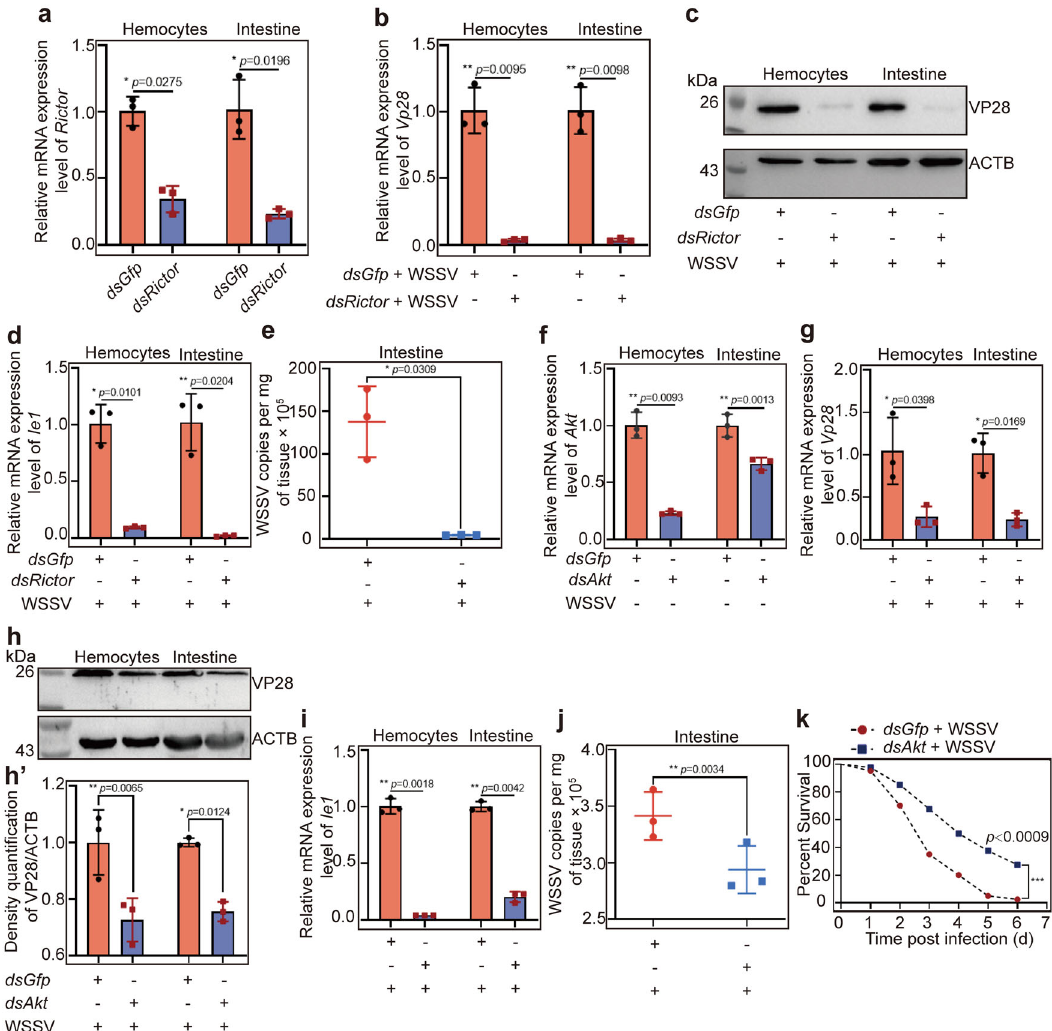
Fig. 6 mTORC2-AKT signaling activation promotes WSSV replication. a The ef fi ciency of Rictor interference assays in hemocytes and intestines. b , c Vp28 expression at the mRNA ( b ) and protein ( c ) levels in hemocytes and intestine of Rictor -knockdown shrimp following WSSV challenge, analyzed using qPCR and western blotting. d , e Ie1 expression ( d ) and copy number ( e ) of WSSV in the shrimp. f The ef fi ciency of Akt RNAi in hemocytes and intestines. g , h Vp28 expression at the mRNA ( g ) and protein ( h ) levels in hemocytes and intestine of Akt-knockdown shrimp following WSSV challenge, analyzed using qPCR and western blotting. h ′ is the statistical analysis of panel h based on three replicates. I , j Ie1 expression ( i ) and copy number ( j ) of WSSV in the shrimp. k Survival rate of the dsAkt -injection shrimp challenged by WSSV ( n = 40), dsGfp injection shrimp challenged by WSSV was used as the control group ( n = 40). Signi fi cant differences were analyzed using the log-rank test in GraphPad Prism 8.0 software. All results are shown by means ± SD for experiments performed at least three times; the data were analyzed statistically using Student ’ s t test. * P < 0.05; ** P < 0.01; *** P <